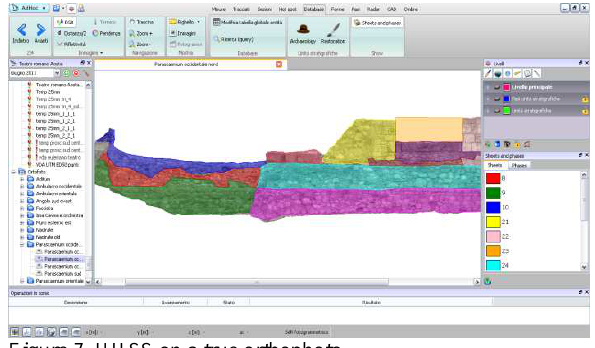
Figure 7. UUSS on a true